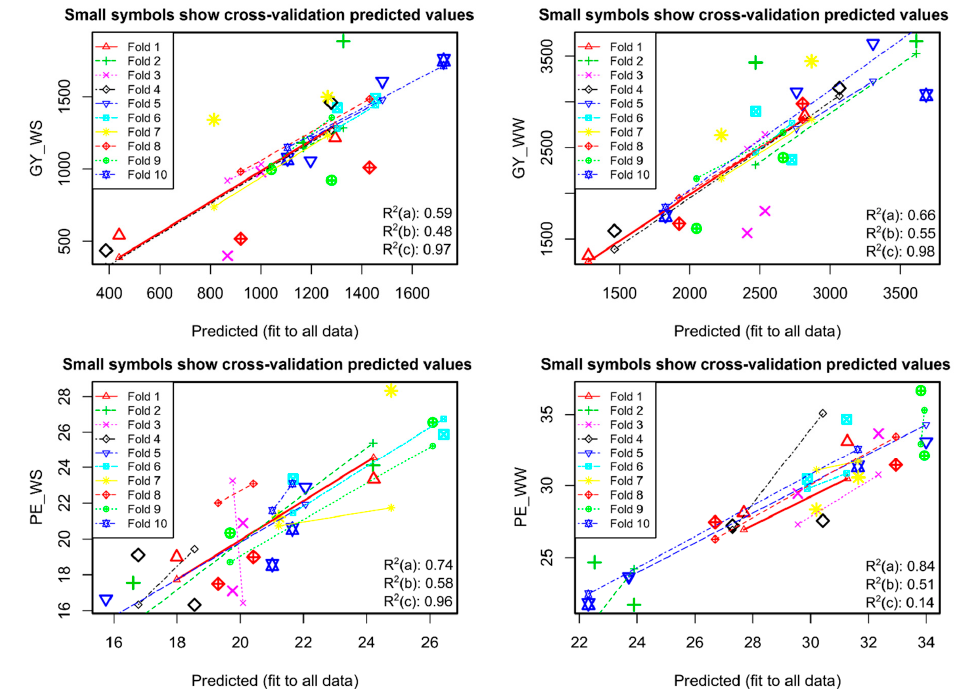
Figure 8. Regressions based on the predicted values of 10-fold cross-validation in each of the four models selected for the response variables: GY_WS (grain yield under water stress), GY_WW (grain yield under well-watered conditions), PE_WS (popping expansion under water stress) and PE_WW (popping expansion under well-watered conditions). The R 2 values corresponded to the coefficients of determination between: (a) observed versus adjusted values, (b) observed values versus values adjusted by the folds and (c) adjusted values versus values adjusted by the folds. 3.1. Effect of Water Restriction on GY, PE, Morpho-Agronomic Traits and on the Greenness Index Grain yield and popping expansion were the traits most affected by water restriction in the soil, with reductions of 55% and 28%, respectively. According to Kamphorst et al. (2020) [20], in response to WS applied during the pre-flowering and grain filling of pop- corn, the effect of reduction on yield covariates was weaker, e.g., on number of grains per row, grain rows per ear and ear diameters and lengths. However, the sum of these effects